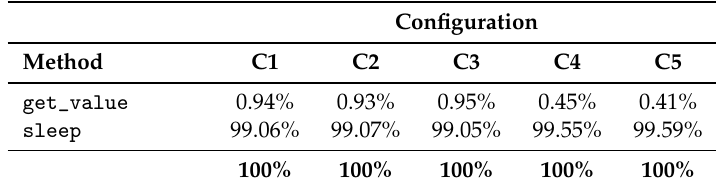
Table 3. Time profiling results for the Plotting process into its two sub-threads: get_value and sleep methods represent the active and inactive action, respectively, of the clock object which manages the plotting of the data.